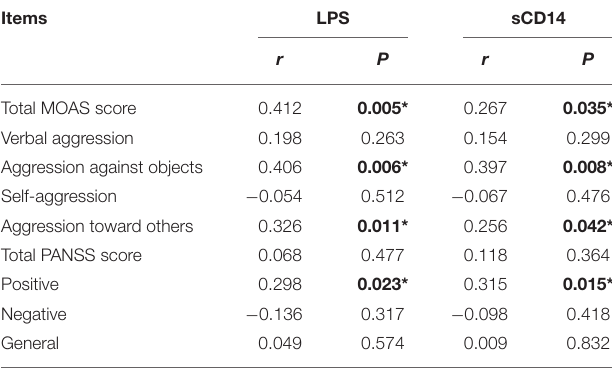
TABLE 3 | Correlations of Lipopolysaccharide or sCD14 with severity aggression.